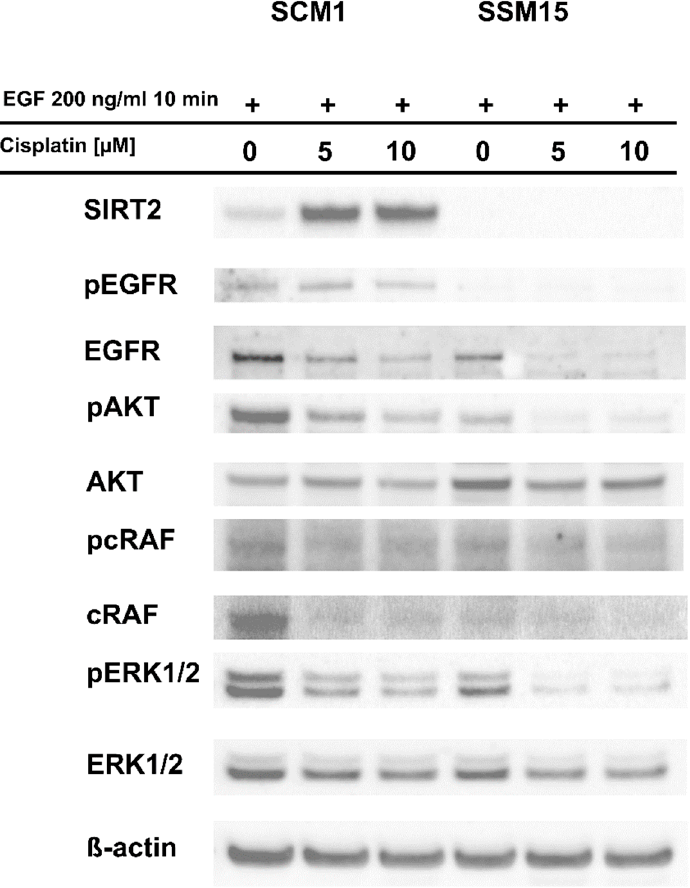
Figure 2. SIRT2 downregulation impairs the response of melanoma cells to EGF and cisplatin. The generated melanoma clones (SCM1 and SSM15 clones) were treated with selected concentrations of cisplatin for 48 h and then treated with EGF (EGFR activator) for 10 min, and protein lysates were prepared and analyzed by Western blotting.